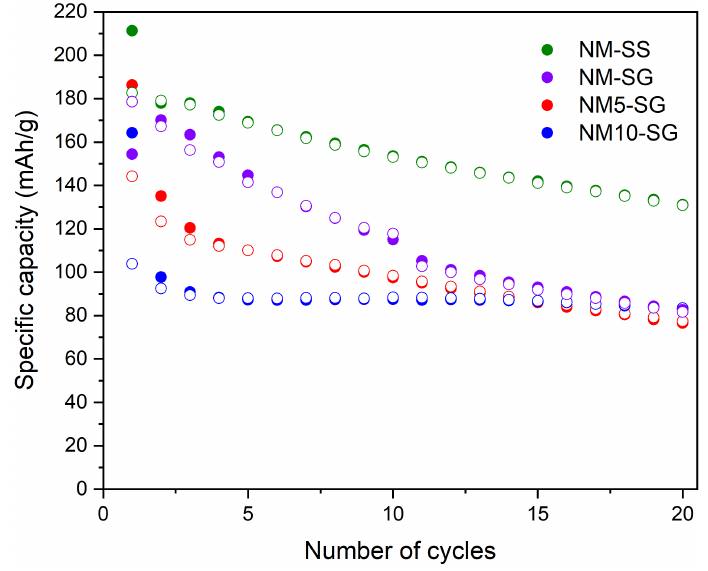
Figure 6. Performance of the four materials during 20 charge/discharge